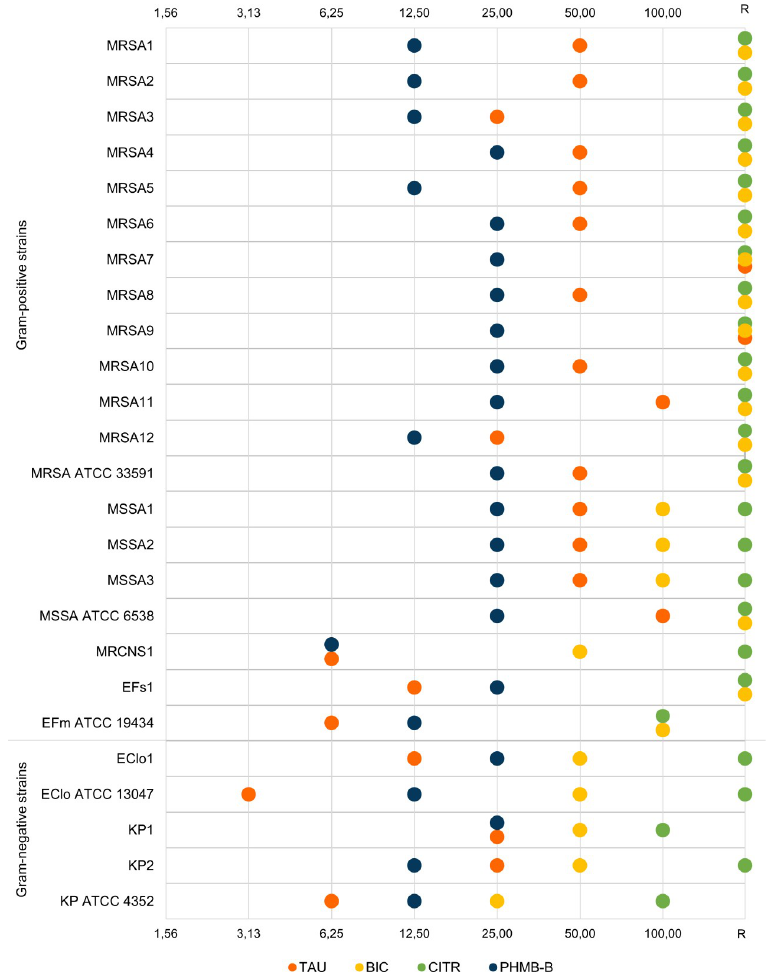
Fig 2. Minimum concentrations [%] of the compounds able to eradicate biofilm (MBEC). TAU–taurolidine, BIC– bicarbonate, CITR—trisodium citrate, PHMB-B–polyhexanide-betaine, R–no activity within the tested